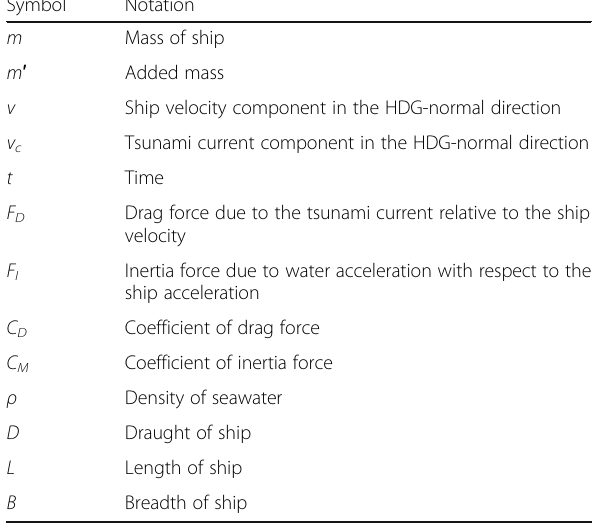
Table 2 Notation used in equations